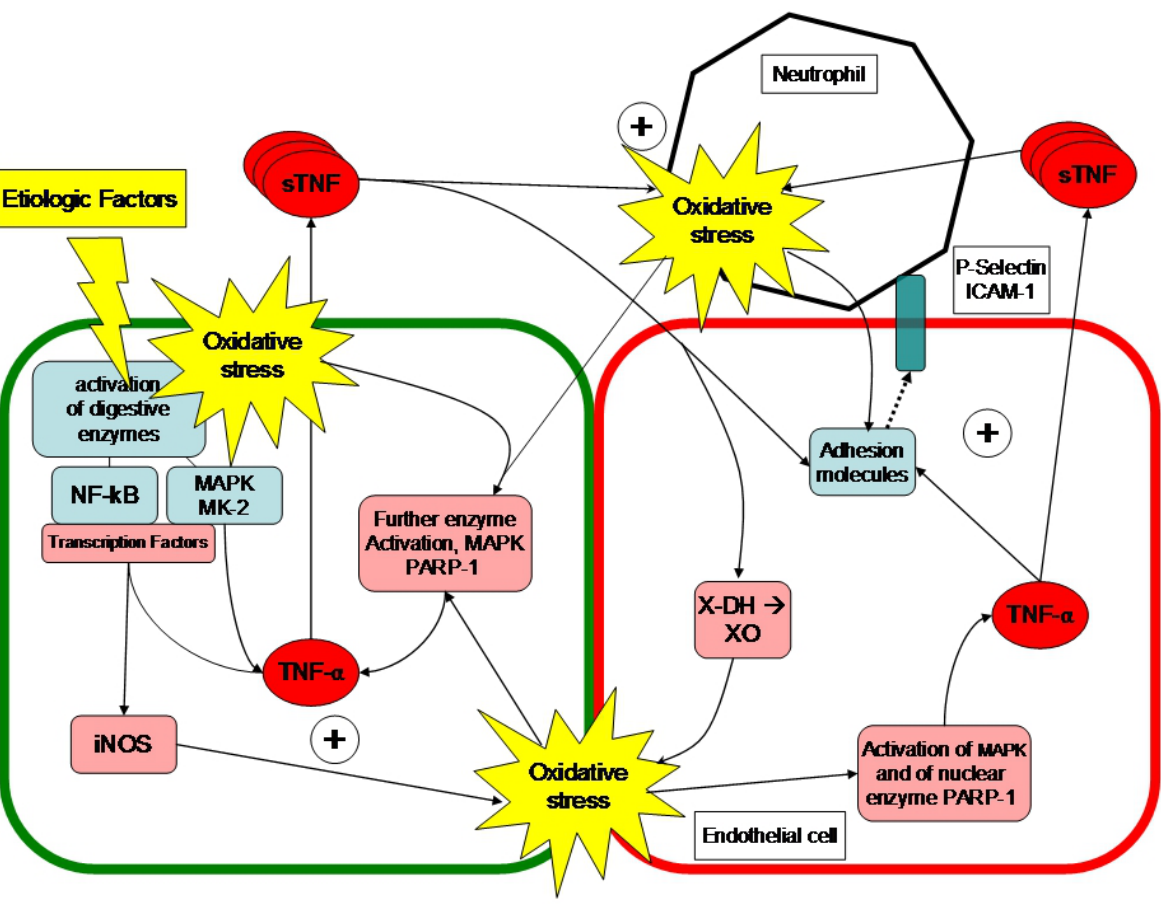
FIGURE 2. The vicious circle generated by TNF- α , adhesion molecules, neutrophils, and oxidative stress. ROS are initially produced in acinar cells, endothelial cells, and neutrophils. TNF- α up-regulates the expression of adhesion molecules, activates neutrophils, and converts xanthine dehydrogenase into xanthine oxidase in endothelial cells. Oxidative stress enhances the activation of the nuclear enzyme PARP-1 and of MAPK. PARP-1 and MAPK account for further production of TNF- α . sTNF = soluble TNF- α ; NF-kB = nuclear factor kB; iNOS = inducible nitric oxide synthase; ROS = reactive oxygen species; MAPK = mitogen activated protein kinases; MK-2 = mitogen activated protein kinases activated protein kinase 2; PARP-1 = poly(ADP-ribose) polymerase; X-DH = xanthine dehydrogenase; XO = xanthine oxidase.